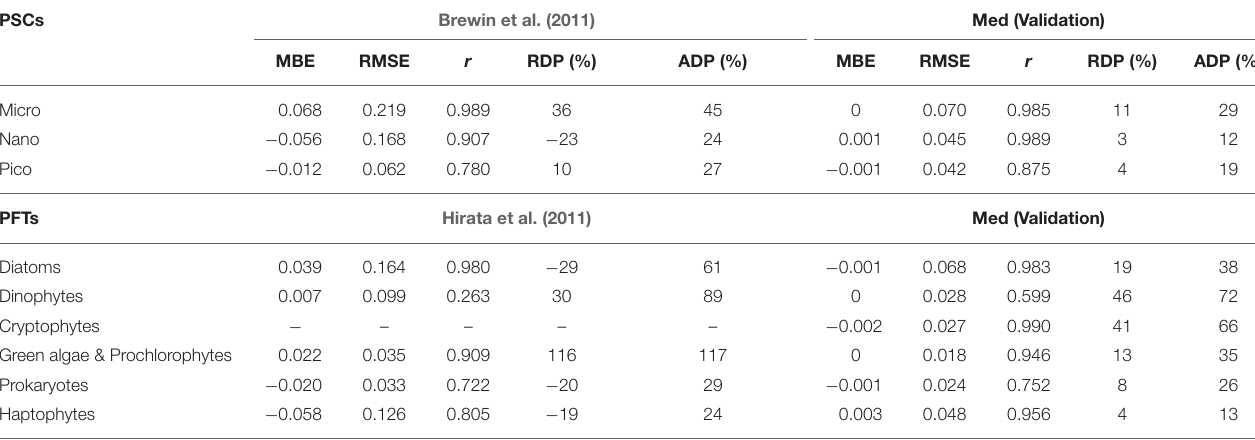
TABLE 7 | Statistical results of the new regional algorithms (Med) validation compared with the statistics resulting by applying the global models (Brewin et al., 2011; Hirata et al., 2011) on the same validation dataset (30% of the entire subset = 413 data).